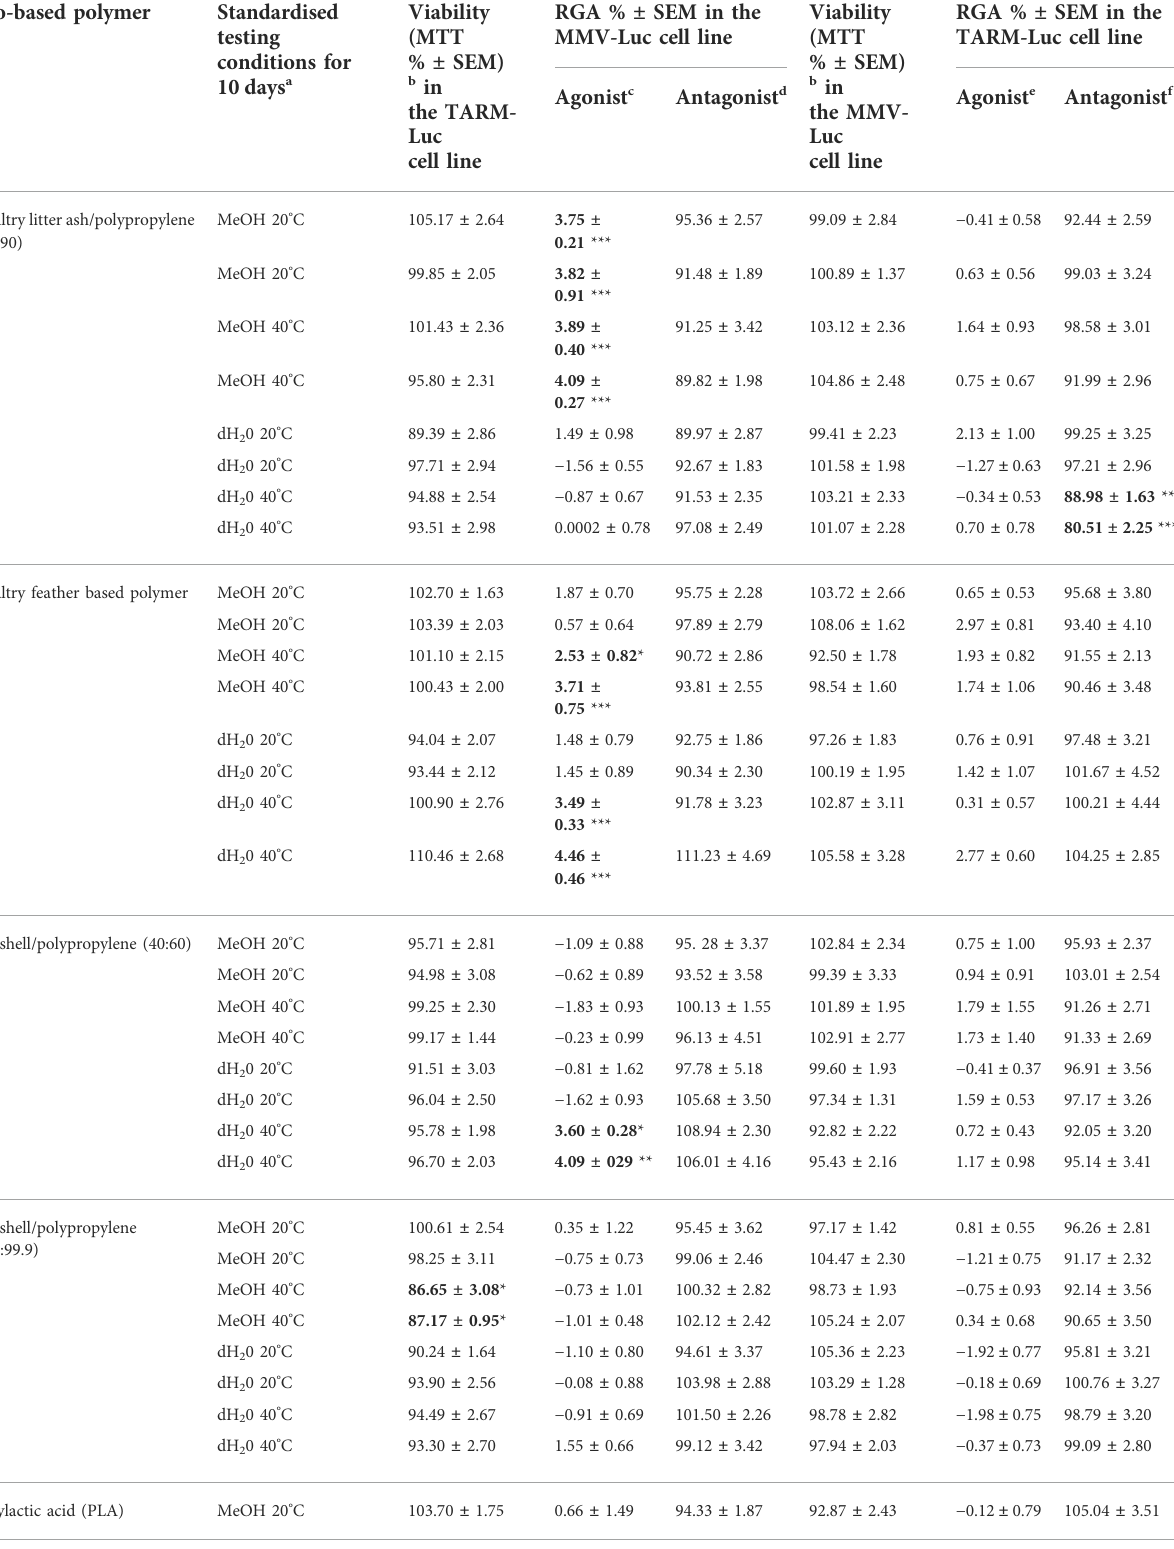
TABLE 4 The bio-based polymers which leached hormonal activity as measured by RGA and the MMV-Luc (estrogen responsive) and TARM-Luc (androgen responsive) cell lines. Bio-based polymer